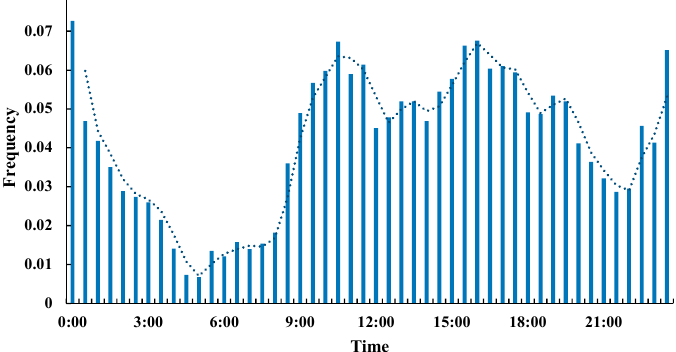
Figure 4. Initial charging time sample distribution of social vehicles.